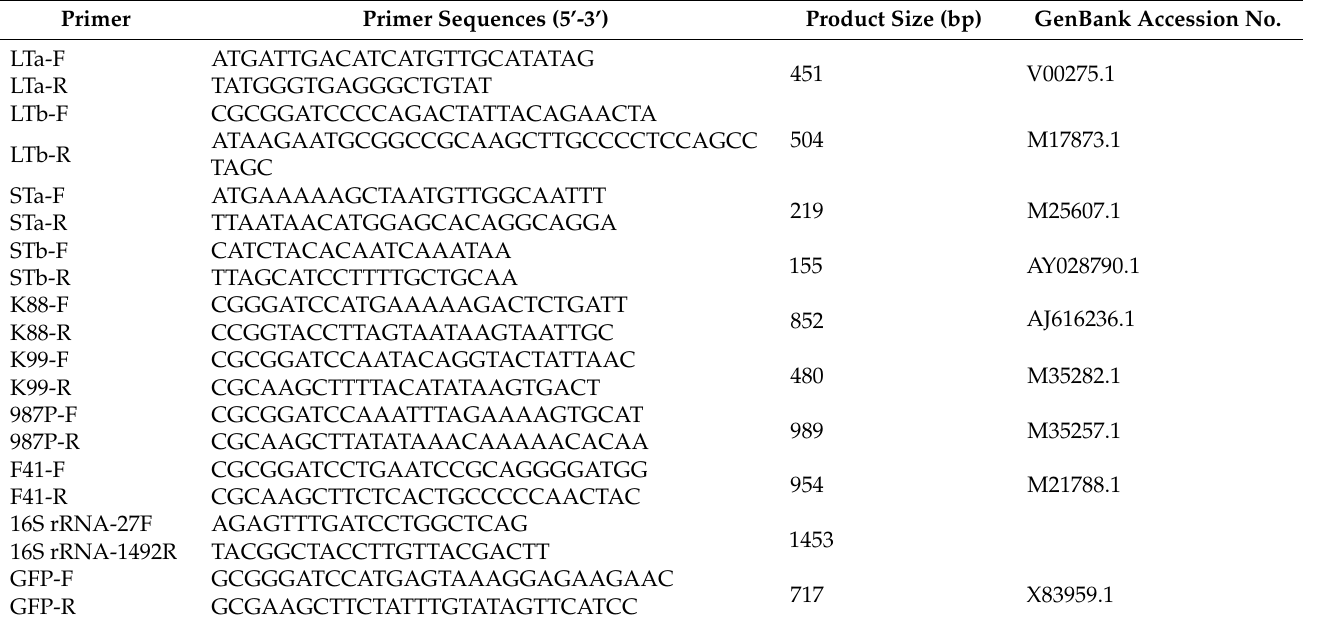
Table 2. Primers used for